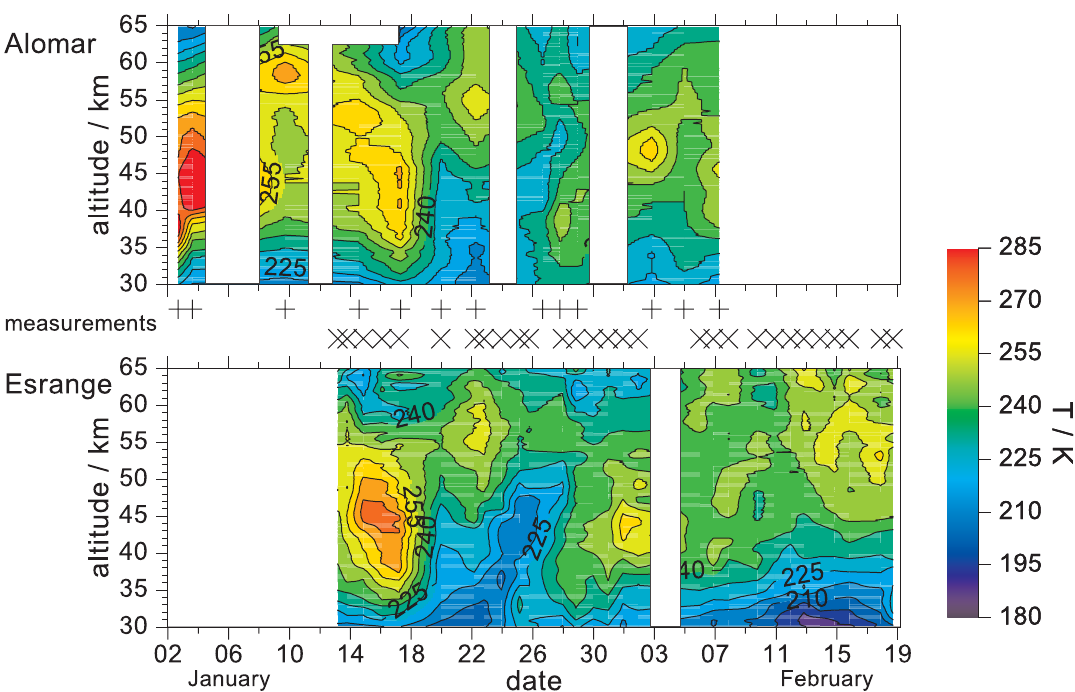
Fig. 2. Temperature development observed with the ALOMAR RMR lidar in Norway (upper panel) and the U. Bonn lidar at Esrange in Sweden (lower panel) for January/February 2003. On the abscissa is the date of January/February 2003, on the ordinate the altitude in km and colour coded the temperature in K. Measurement times are marked by plus-signs (+) for ALOMAR data and by crosses ( × ) for Esrange